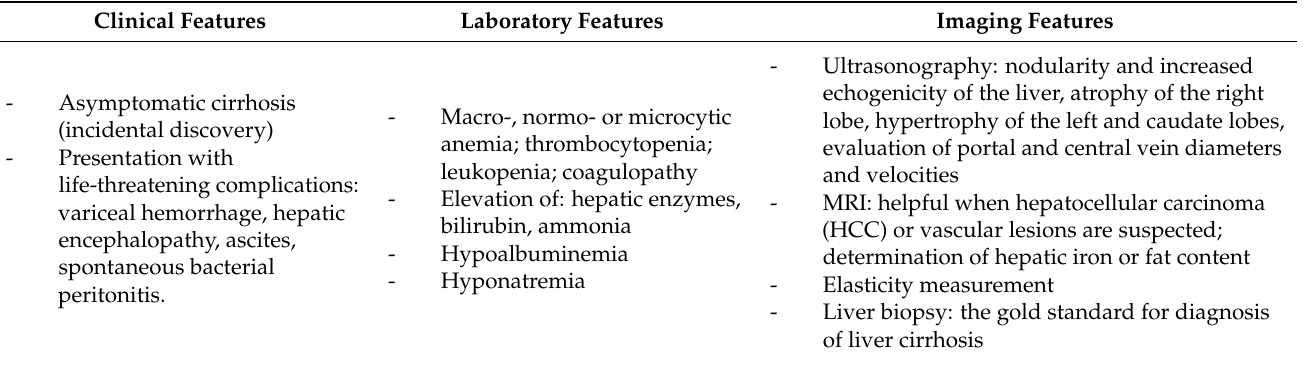
Table 10. Diagnosis of liver cirrhosis in pregnant women. Data from Ref [113].